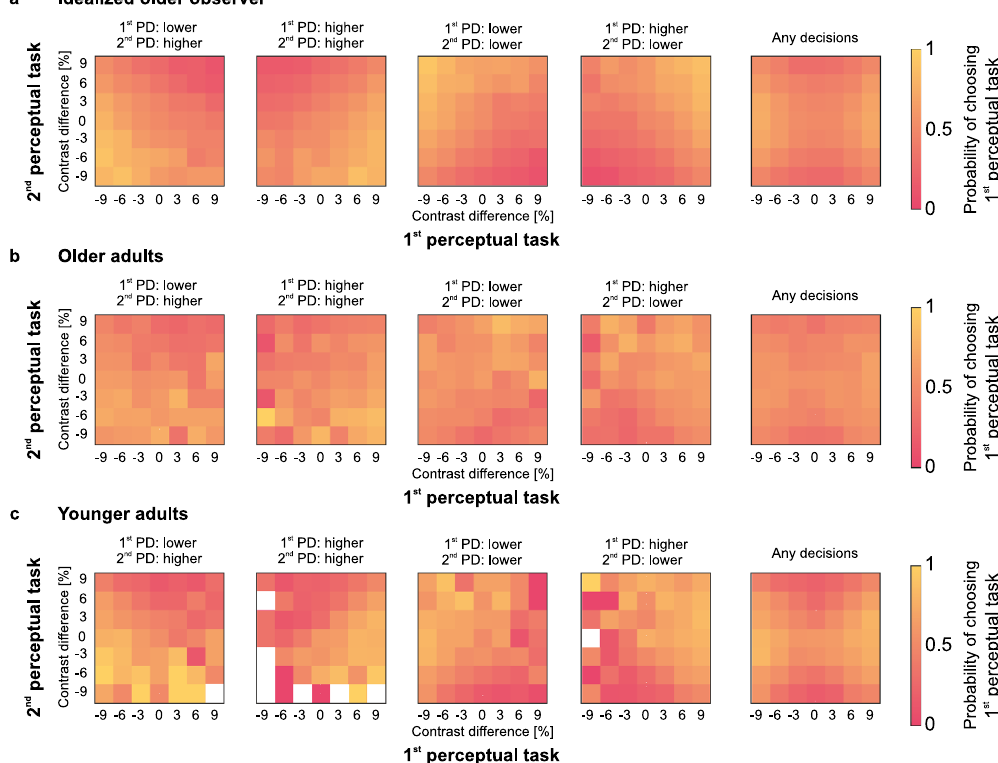
Figure 3. Descriptive illustration of metacognitive abilities in visual perception giving ( a ) an idealized older observer simulated to have a sensory noise equal to the average of the older adults, ( b ) older adults, and ( c ) younger adults. The first four plots in each panel show the probability of choosing the 1st perceptual decision (PD) as the most likely to be correct in the confidence judgement, i.e., associating it with relatively higher confidence, for each of the four possible combinations of perceptual decisions in the two consecutive contrast discrimination tasks. Decisions here apply to the test patches, i.e., code whether the test patches were indicated as lower or higher in contrast than the standard. The last plots on the right show the probability across all trials. The x - and y -axes give the contrast difference between the test patches and the standard patch in the first and second perceptual tasks, respectively. Metacognitive ability is indicated in these plots by a pattern of probabilities that dynamically depends on task difficulty, i.e., absolute contrast difference, and correctness of the perceptual decisions in both consecutive tasks. White cells in these plots represent the specific combination of consecutive perceptual decisions and stimulus strengths that did not occur in our data